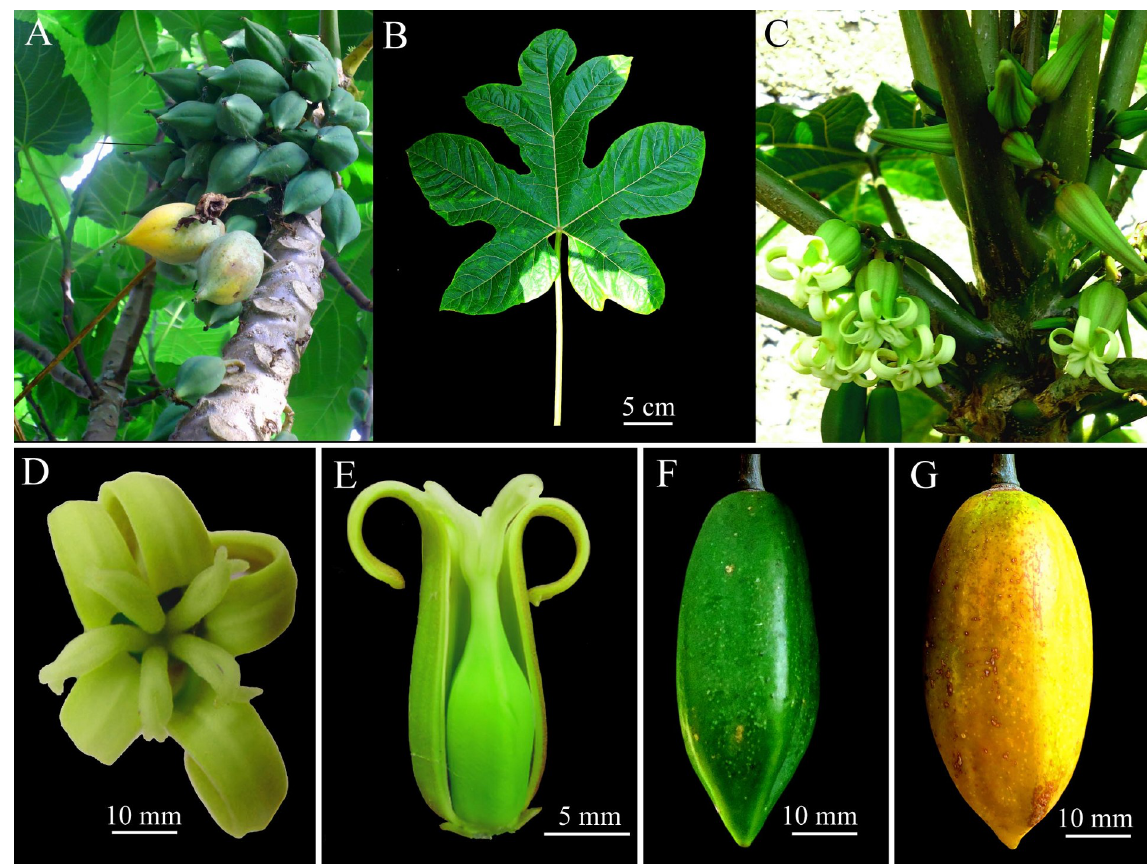
Fig 4. Morphology of Vasconcellea carvalhoae (CHAX227). A, Habit. B, Palmately compound leaf. C,. Female inflorescence. D, E, Female flowers with stigmas split into 2–3 ends (D) and superior ovaries (E). F, Immature fruit. G, Mature